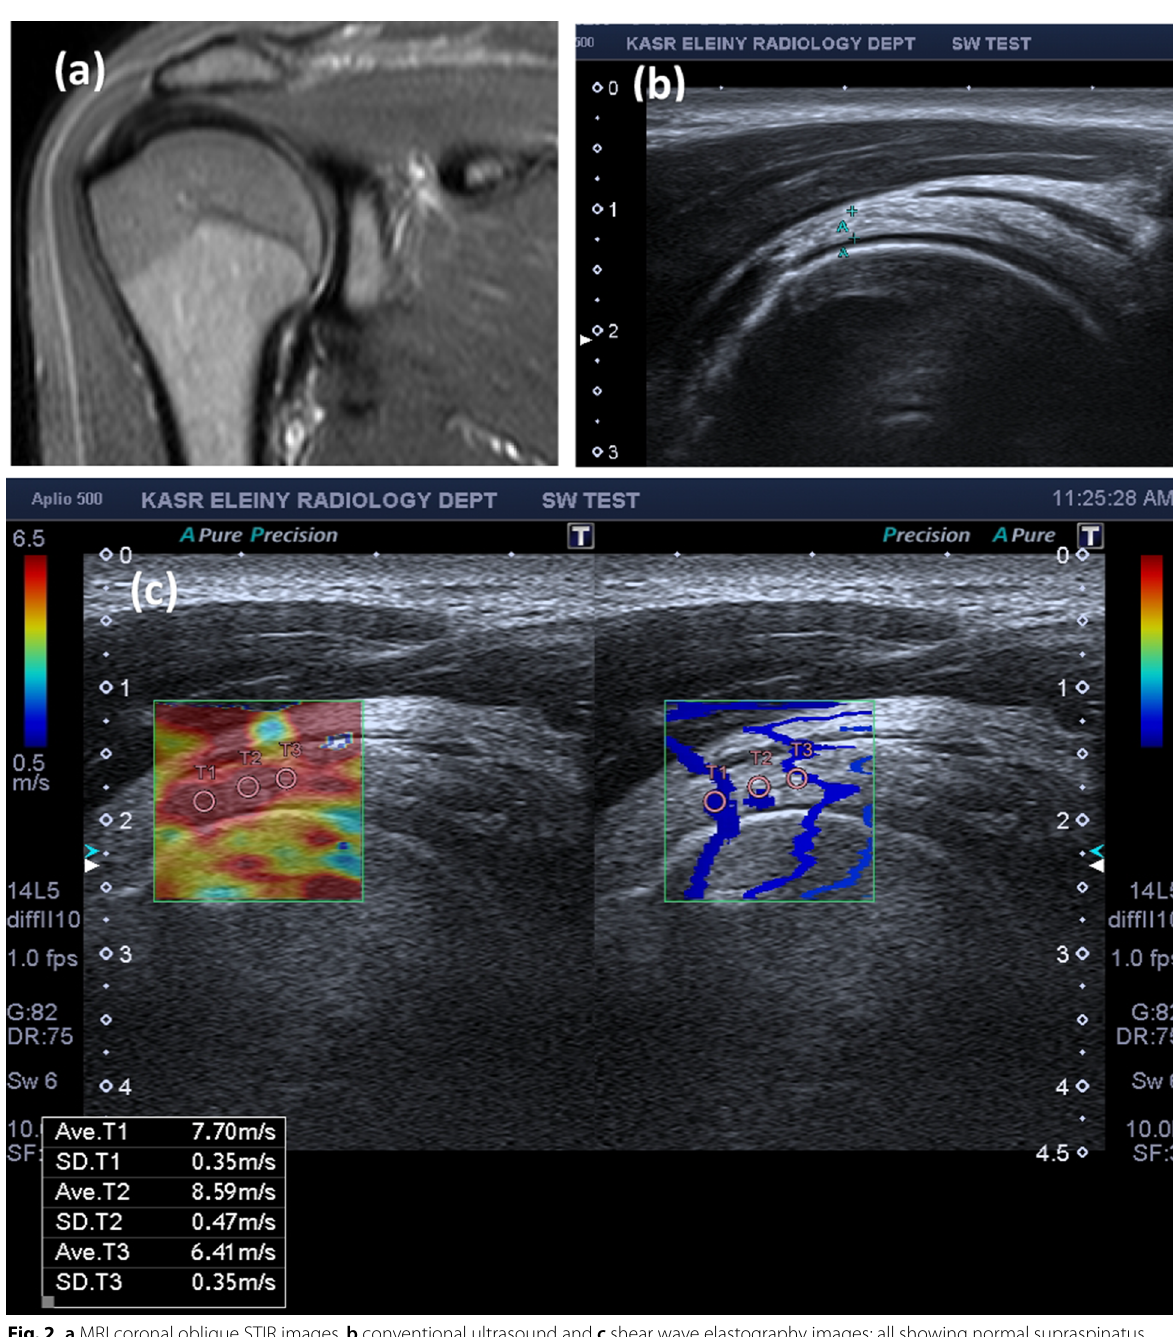
Fig. 2 a MRI coronal oblique STIR images, b conventional ultrasound and c shear wave elastography images; all showing normal supraspinatus tendon with homogenous stiff pattern (red color) on elastography with average SWV equal to 7.5